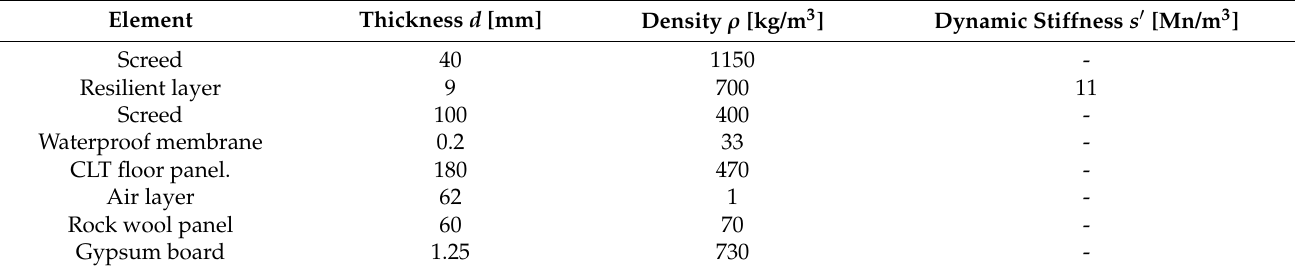
Figure 6. Configuration 4: Bare floor coupled with floating floor and suspended ceiling.